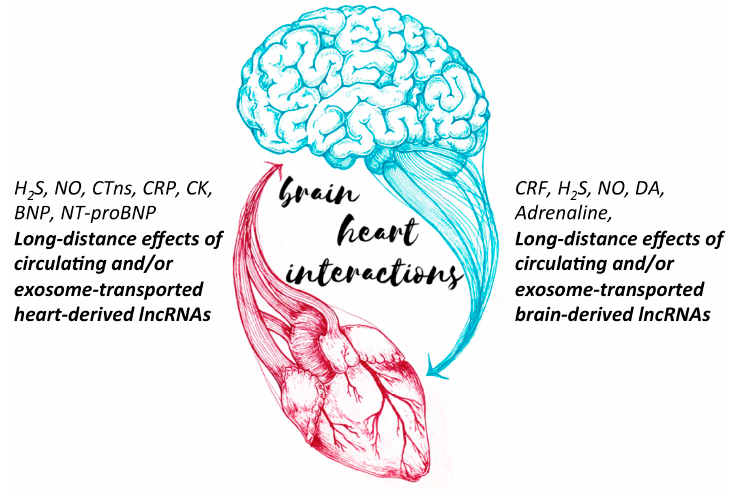
Figure 1. Two-way traffic of signaling molecules and noncoding RNAs drives the brain–heart